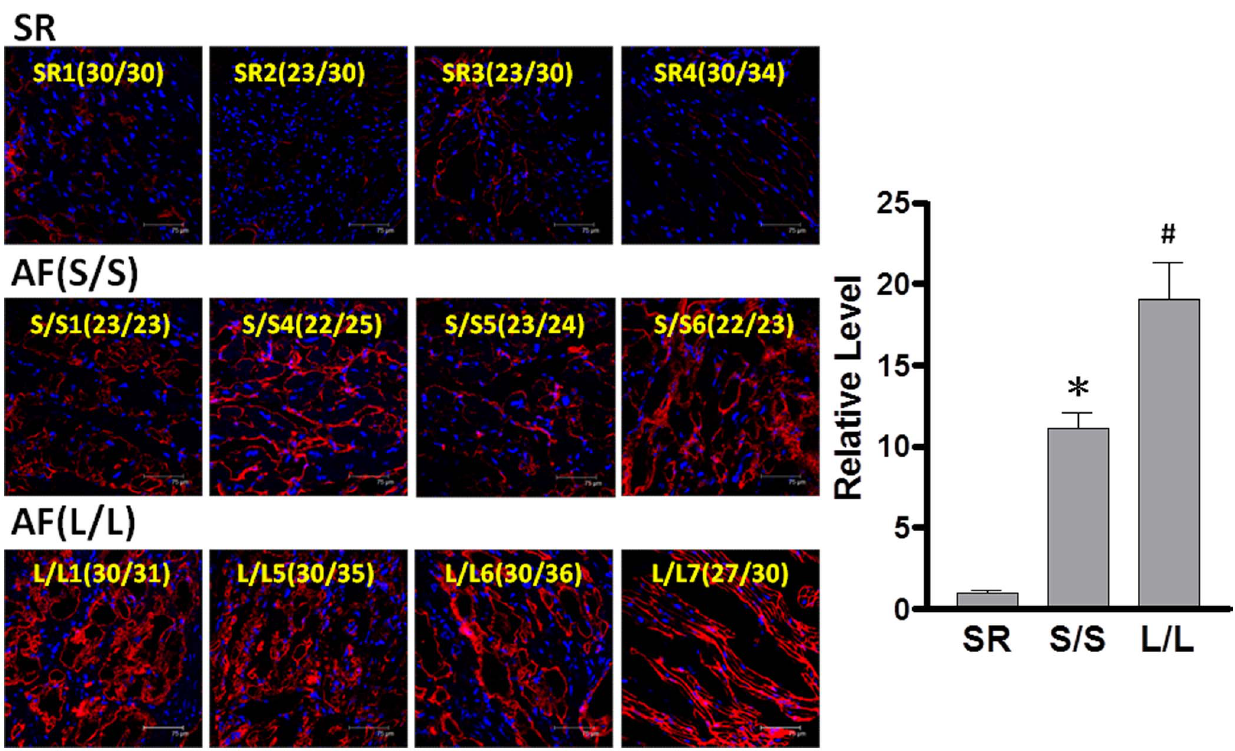
Figure 5. Association of the GT-repeat length polymorphism with fibrosis in AF tissues. Representative confocal images show fibrosis in the atria of 8 AF patients and 4 controls (sinus rhythm subjects [SR], left). Relative intensity of collagen I was quantified (right). Data are expressed as mean 6 SE. P , 0.05; *, # : the different symbol represents the significant difference among groups.